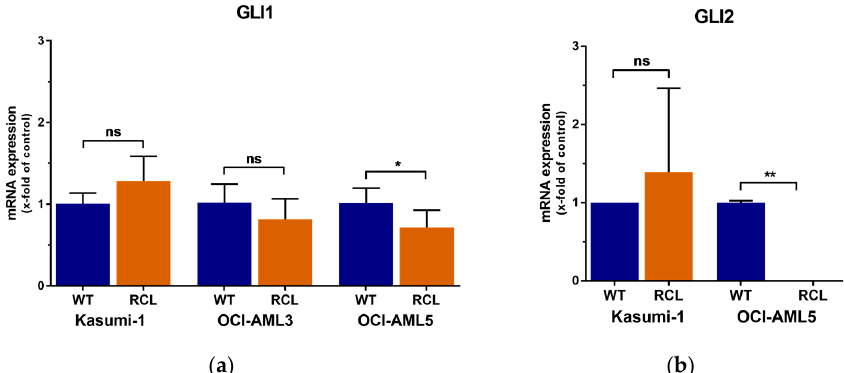
Figure 2. No consistently significant changes in GLI1 and GLI2 mRNA expression in Ara-C-resistant cell lines. ( a ) WT and Ara-C RCL Kasumi-1, OCI-AML3, and OCI-AML5 were analyzed for GLI1 and GLI 2 mRNA levels by RT-qPCR. Relative GLI2 expression could not be analyzed for OCI-AML3, as the GLI2 expression levels were below the detection level. Error bars represent the mean values ± standard deviation; * p < 0.05, ** p < 0.01 in the Welch’s t -test; ns, not significant.